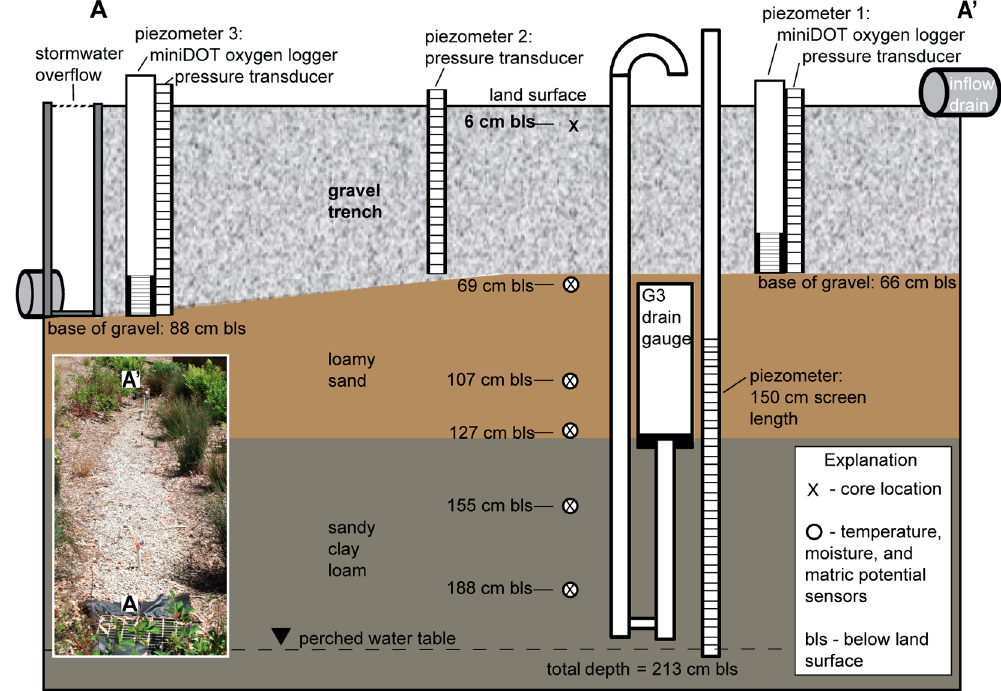
Figure 2. Schematic depiction (not to scale) of the instrumentation and core locations along the longitudinal cross-section A–A’ (inset) of the infiltration trench site at San Francisco State University (SFSU) low impact development (LID) research network. Modified from Newcomer et al. 2014 [27].